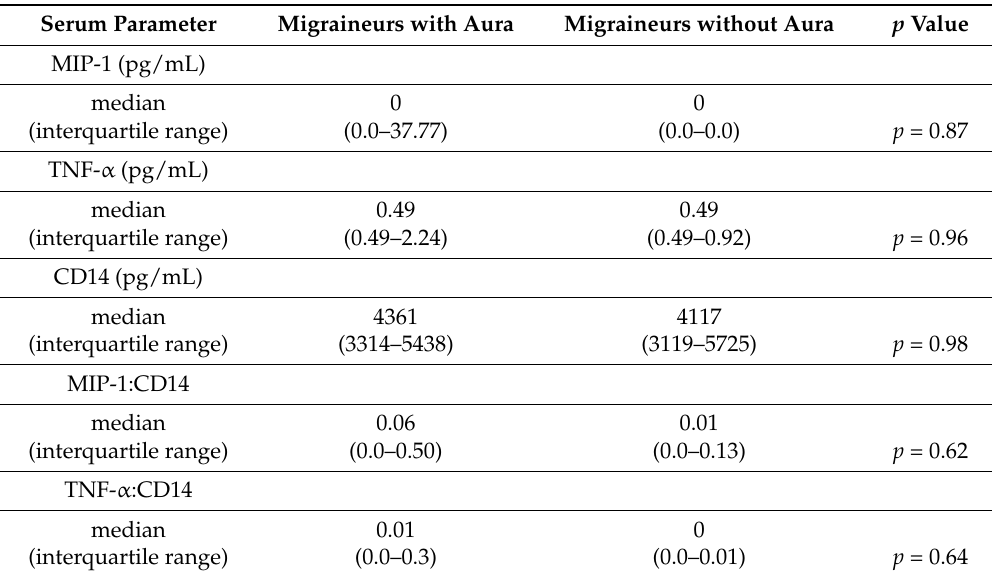
Table 4. Serum levels of MIP-1, TNF- α and CD14, TNF- α :CD14 and MIP-1:CD14 ratios in monocytes in migraine patients with and without aura.